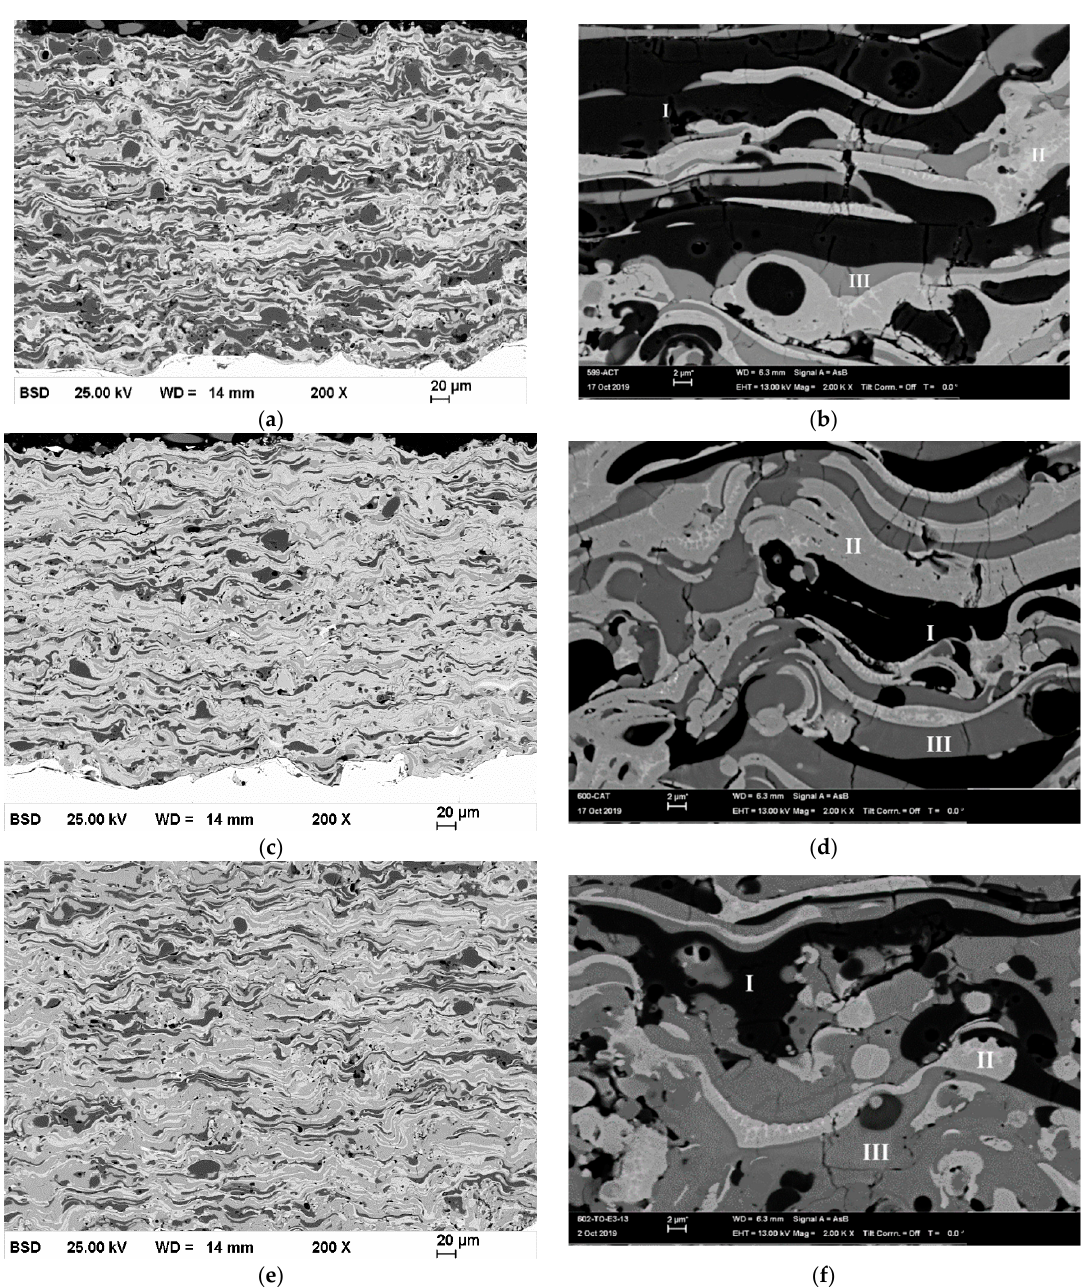
Figure 5. SEM images (BSD detector) of APS Al 2 O 3 -Cr 2 O 3 -TiO 2 composite coatings: top row: ACT-coating: ( a ) overview image, ( b ) detailed image with marked areas for the EDS measurement. middle row: CAT-coating: ( c ) overview image, ( d ) detailed image with marked areas for the EDS measurement. bottom row: TAC-coating: ( e ) overview image, ( f ) detailed image with marked areas for the EDS measurement. The EDS measurements of the marked areas are shown in Figure 6.